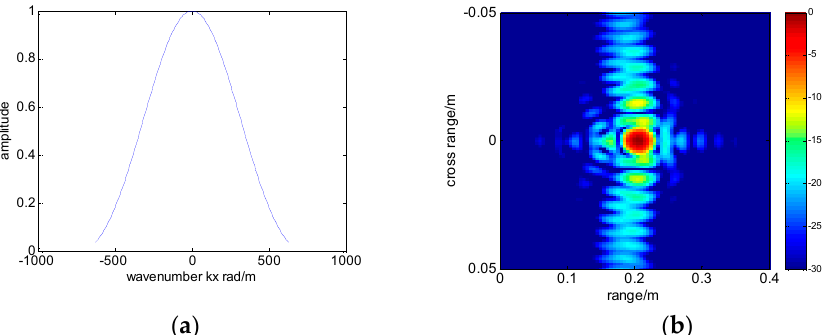
Figure 9. The Kaiser window with beta of 2.5 and its calibration result, ( a ) is Kaiser window and ( b ) is the calibration result.